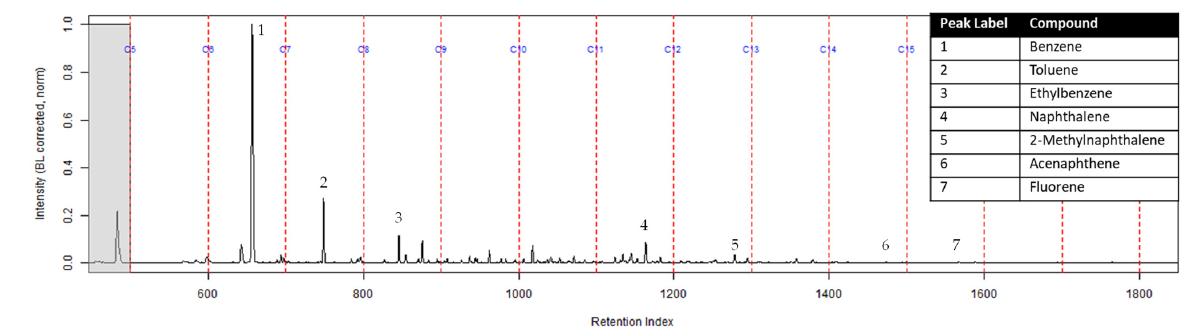
Figure 6. Zoomed TIC of the extract from the activated charcoal strip within the dosimeter not containing ACL from the can containing 2-min MDDM burned vinyl siding and a railroad tie (maximum peak abundance 5.2 × 10 6 ).